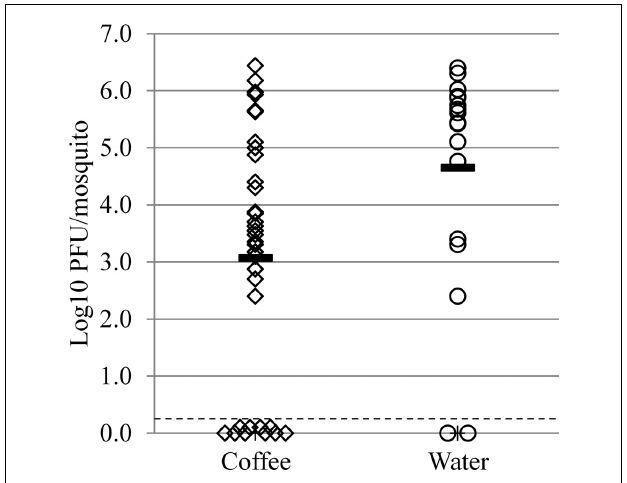
FIGURE 3 | Full-body La Crosse virus titers of Aedes albopictus females reared in 15% coffee extract (diamonds) or distilled water (circles). Solid horizontal lines indicate the mean for each group. Dashed line represents the limit of detection. Means are significantly different by t -test ( p = 0.0090).